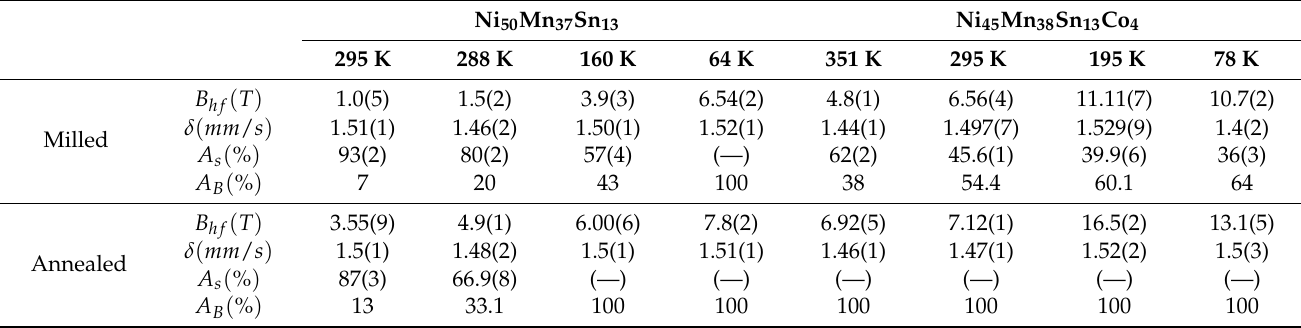
Table 2. The value of B hf ( T ) magnetic hyperfine field, δ ( mm/s ) isomer shift, and the A s ( % ) area of the singlet (area of the sextet A B = 100% − A s ) obtained from the fitting for Ni 50 Mn 37 Sn 13 and Ni 45 Mn 38 Sn 13 Co 4 alloys in both milled and annealed state at the indicated temperatures. δ has been constrained to be the same for both singlet and sextet subspectra